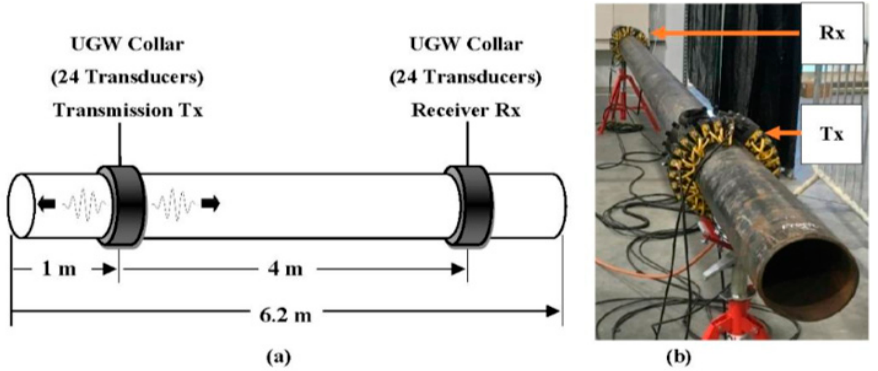
Figure 6. ( a ) Schematic and ( b ) setting-up of the UGW collar arrangement for pitch–catch configura- tion topology [89].